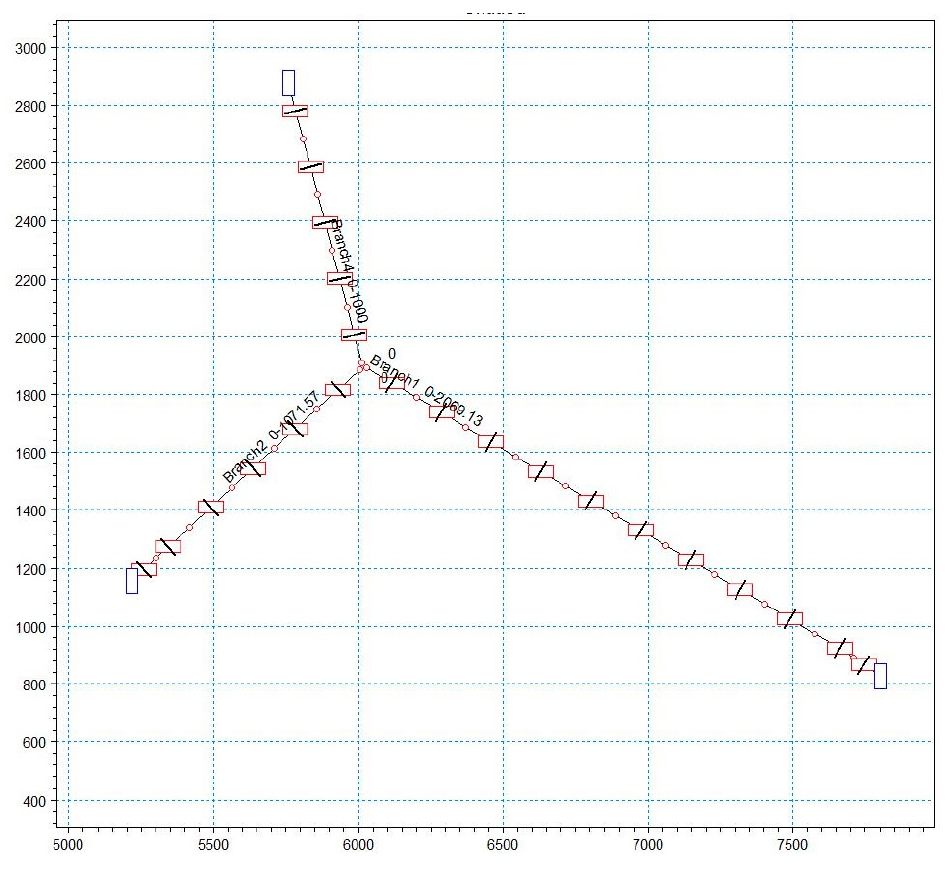
Figure 4. Simple bifurcation with different cross − section spacing.